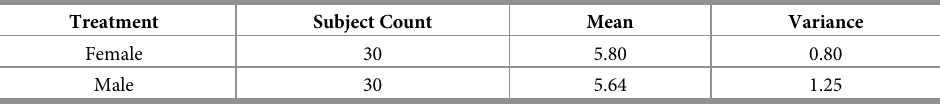
Table 13. Data summary—Viewpoint #3.